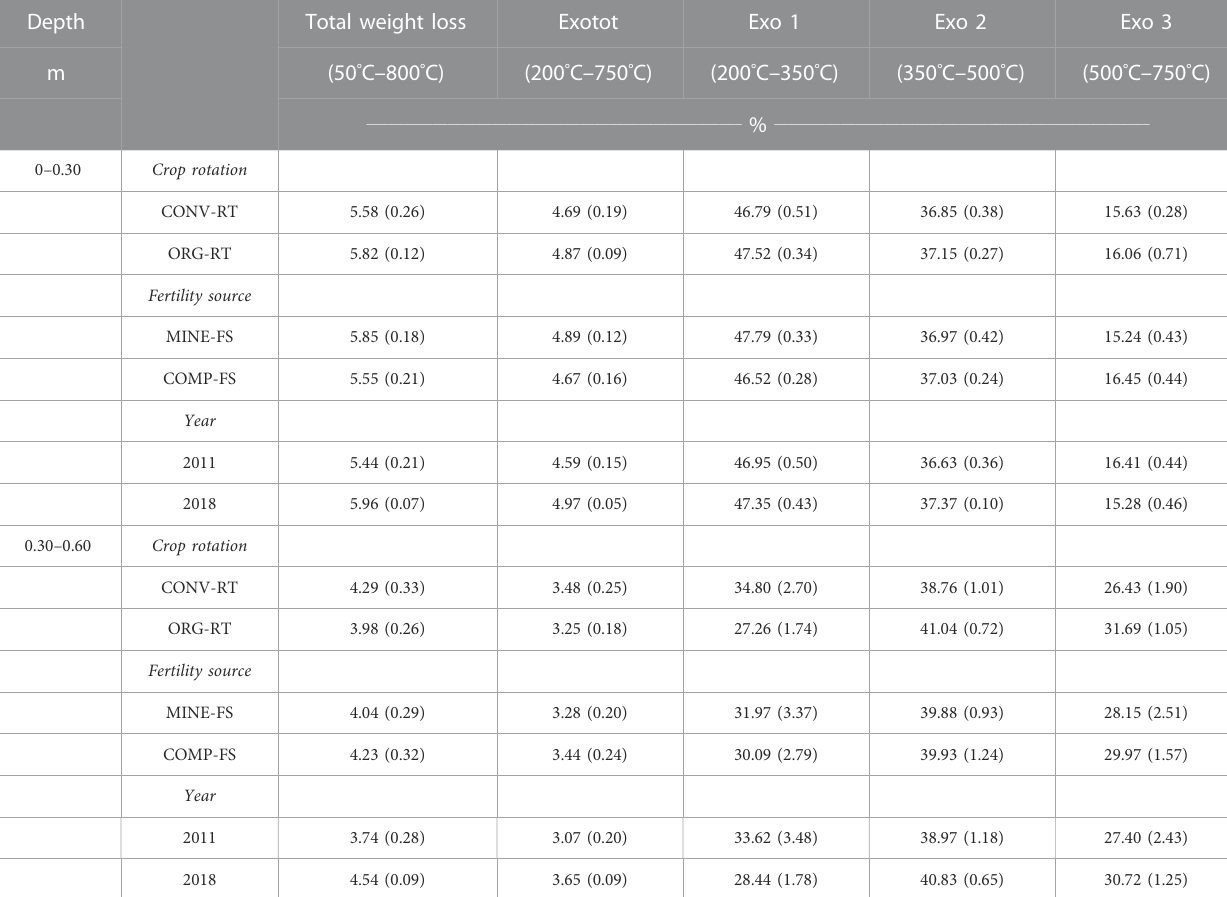
TABLE 4 Changes in total weight loss (50 ° C – 800 ° C), weight loss for the temperature interval 200 ° C – 750 ° C (Exotot) and relative weight losses of temperature intervals 200 ° C – 350 ° C (Exo 1), 350 ° C – 500 ° C (Exo 2) and 500 ° C – 750 ° C (Exo 3) as a result of different crop rotation (conventional-CONV-RT or organic-ORG-RT), fertility sources (mineral-MINE-FS or compost-COMP-FS) and years of sampling (YR) (2011 and